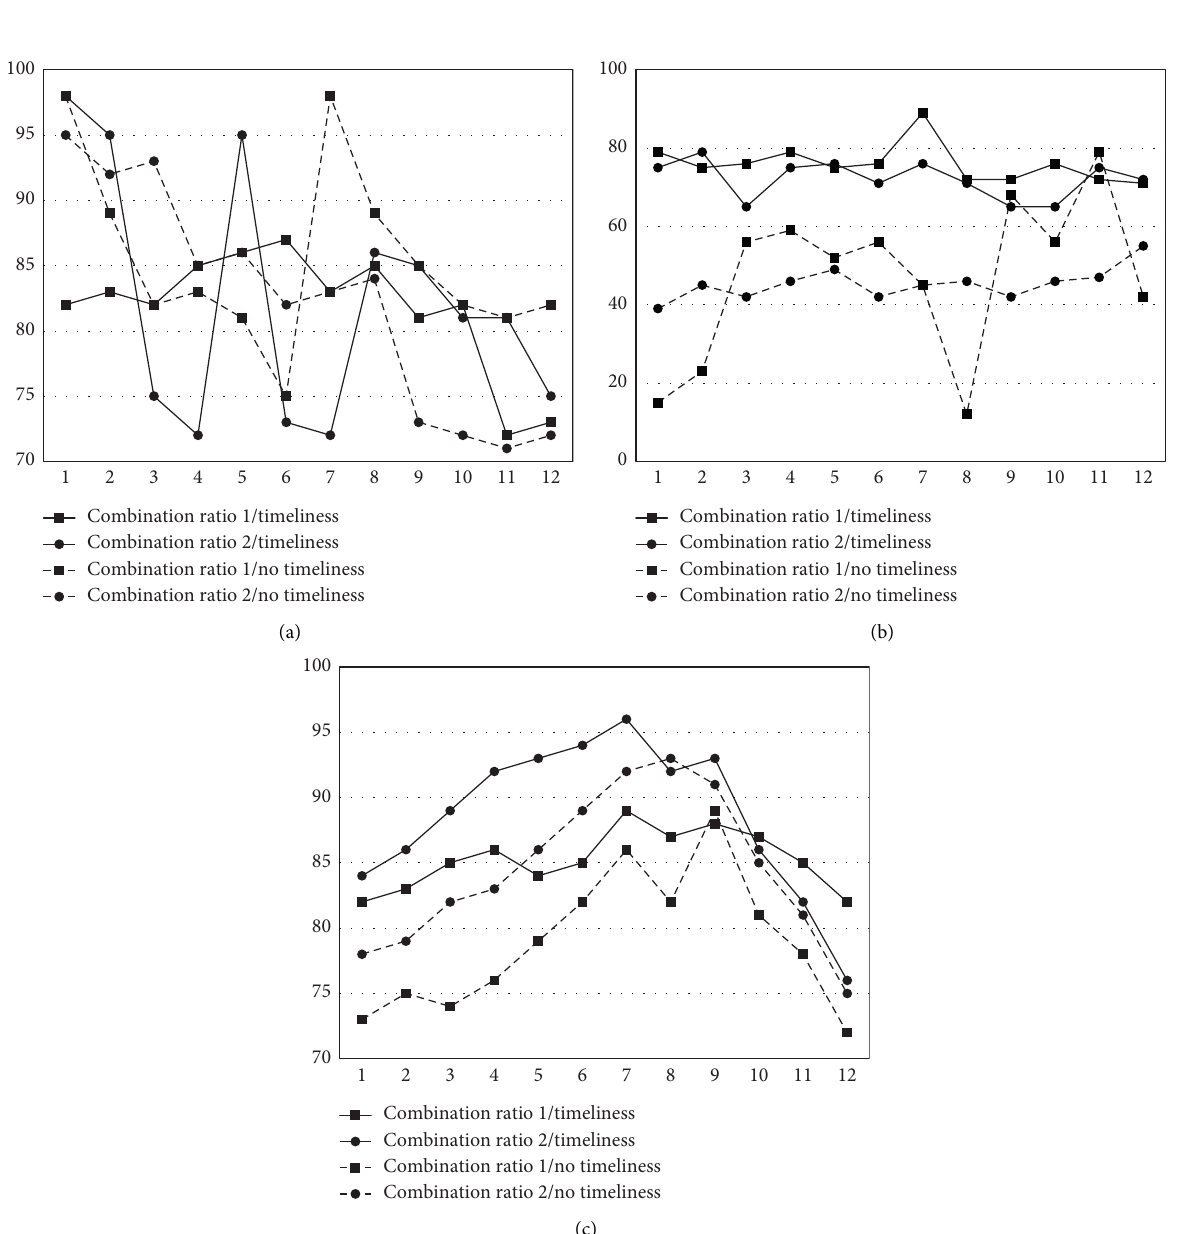
Figure 5: Comparison of model prediction results under diferent combination ratios.